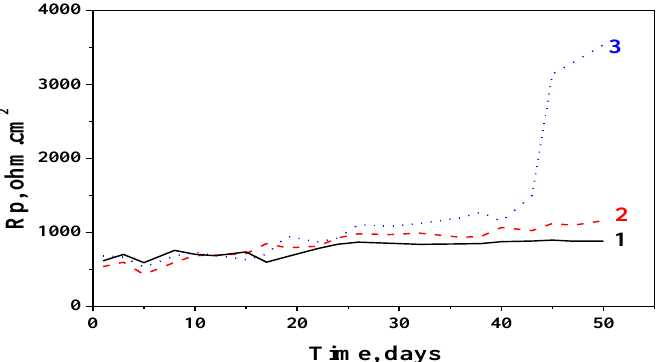
Figure 3. Polarization resistance of ordinary Zn and both hybrid coatings: 1—Zn; 2—Zn-PANI / PVP; 3—Zn-PANI / SiO 2 .